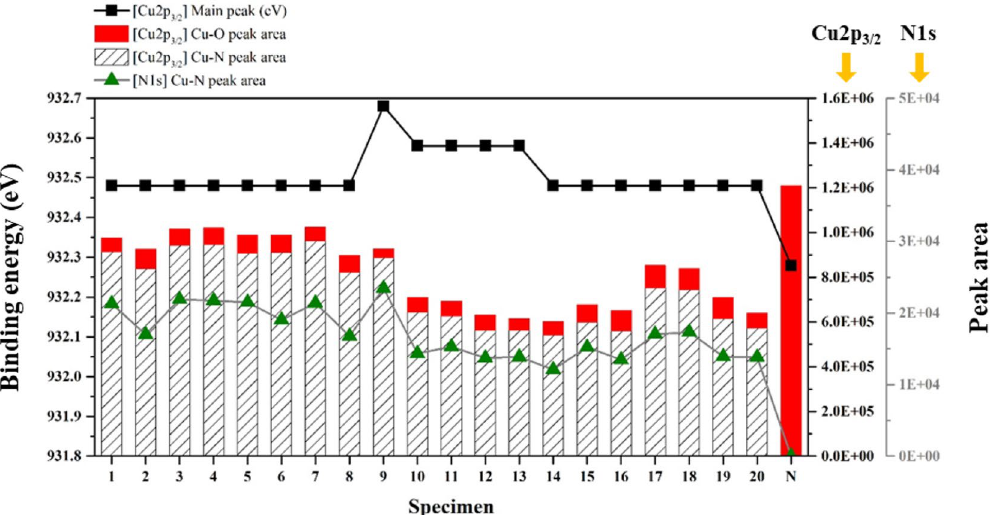
Figure 2. XPS peak analysis by a deconvolution